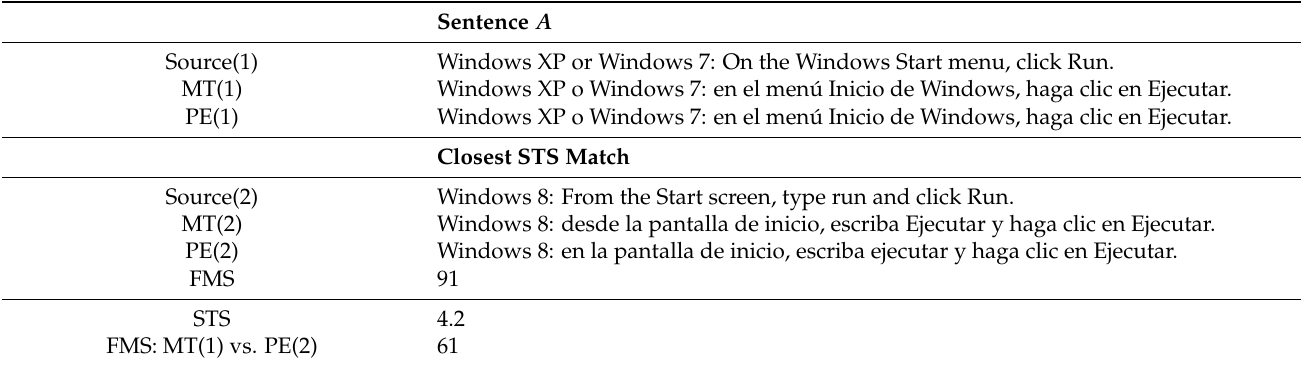
Table 1. Example of STS